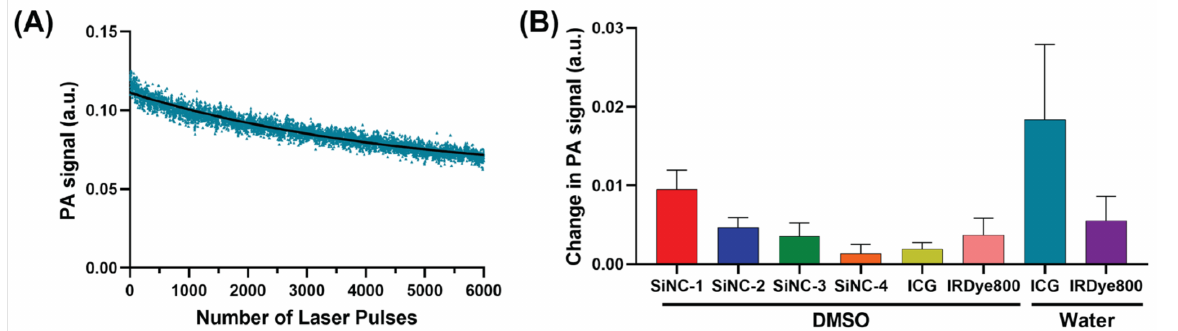
Figure 5. ( A ) Pulse to pulse PA signal of ICG in water acquired with our custom-built photoa- coustic imaging system. ( B ) The total change in PA signal of the various dyes over the course of 3000 nanosecond laser pulses at their wavelengths corresponding to the dye absorption maxima. The results are expressed as mean ± standard deviation ( n =